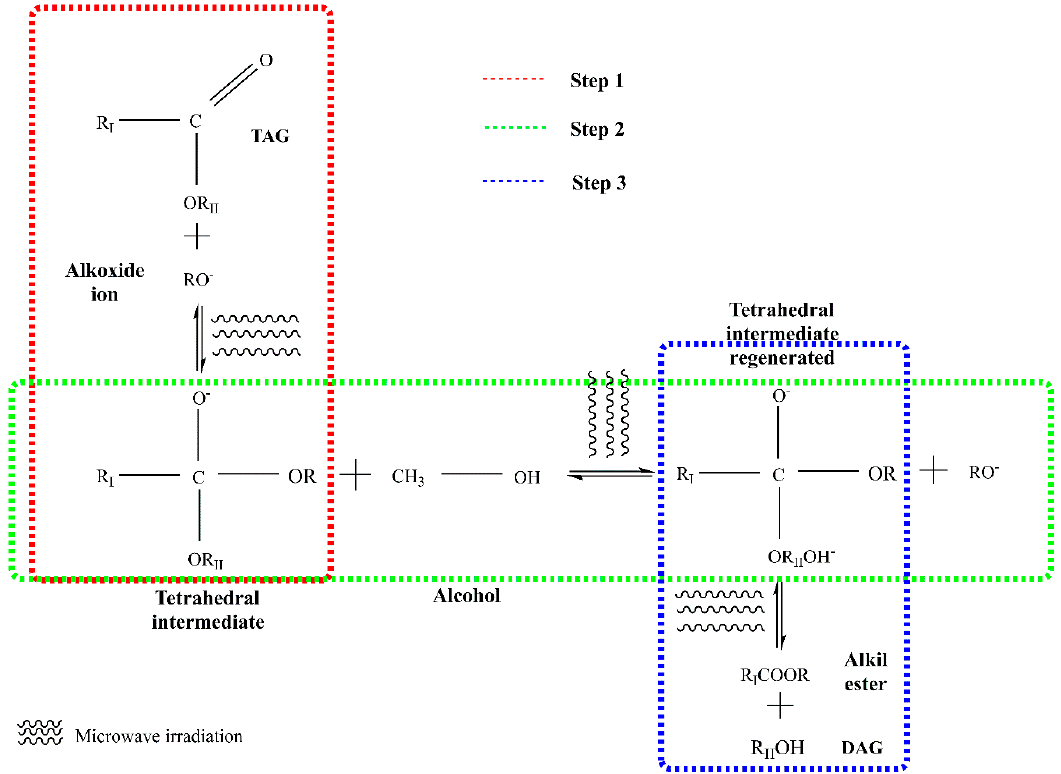
Figure 1. Sequence of the transesterification reaction of oil using alkaline catalysis and microwaves (modified from [49]). TAG: Triglyceride, DAG: Diglyceride, R II : glyceride, R I : carbon chain fatty acid; R: alkyl group of alcohol.